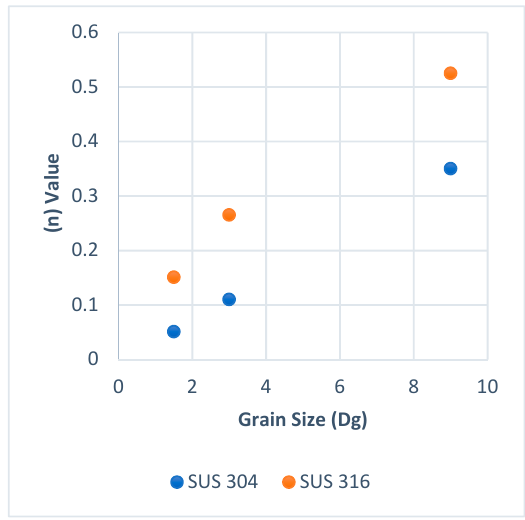
Figure 8. Work hardening room temperature.